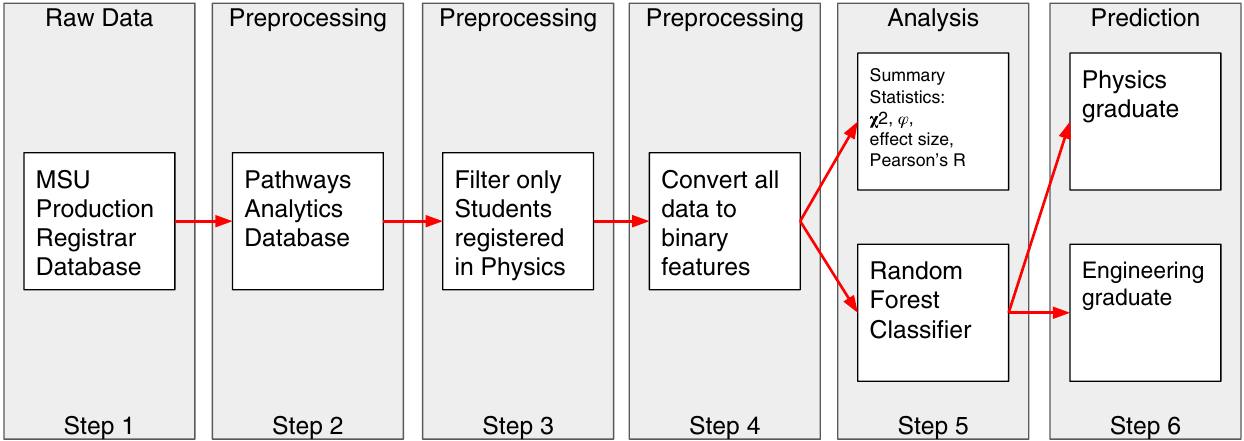
FIG. 1. Raw data are collected by the MSU Office of the Registrar and are used to build the pathways analytics database. The data is filtered to only students who registered as physics majors and then further reduced to binary features. The analysis includes summary statistics (Table I and Fig. 2) and the random forest classifier predicting “ physics graduates ” and “ engineering graduates ” (Figs. 3, 4,